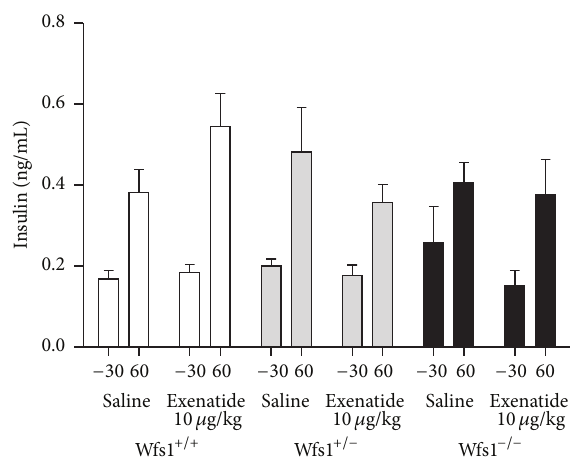
Figure 6: Effect of treatment with exenatide during IPGGT on insulin-to-glucose ratio. Wfs1 +/+ , white bars; Wfs1 +/− , grey bars; Wfs1 −/− , black bars. To compare the glucose-insulin ratio between baseline ( − 30min) and the 60-minute time point, repeated mea- sures ANOVA was used, followed by the Duncan post hoc test, where ∗ 𝑝 < 0.05 versus baseline; ∗∗ 𝑝 < 0.001 versus baseline. To compare the treatment effect at the 60-minute time point, two-way ANOVA was used, followed by the Duncan post hoc test, where # 𝑝 < 0.05 versus saline at the same time point; ## 𝑝 < 0.001 versus saline at the same time point. 𝑛 = 8 in all